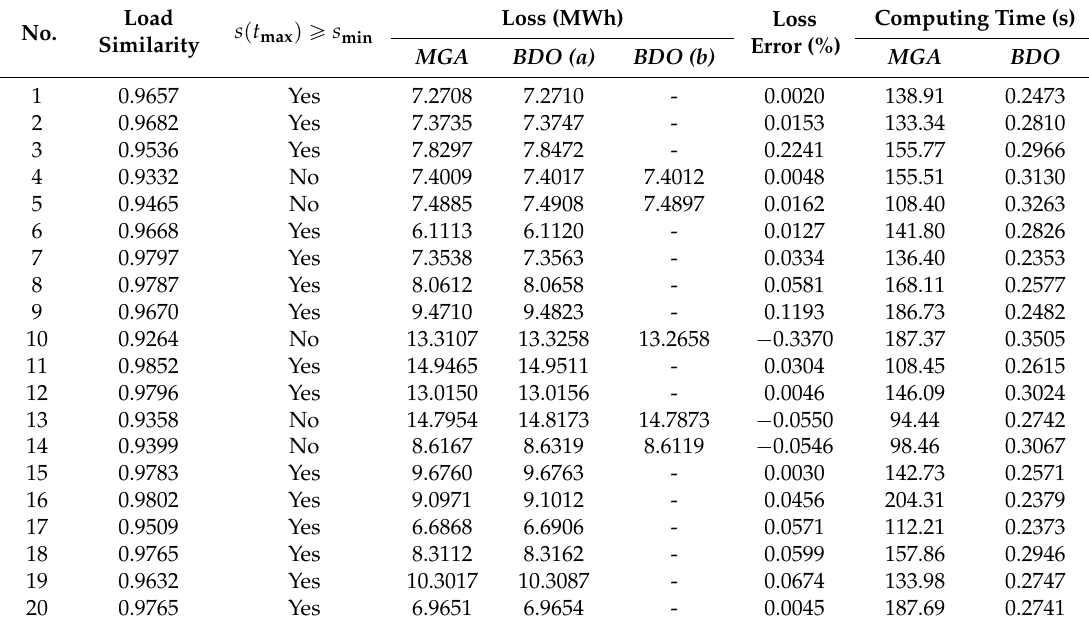
Table 6. Optimization results of 20 random